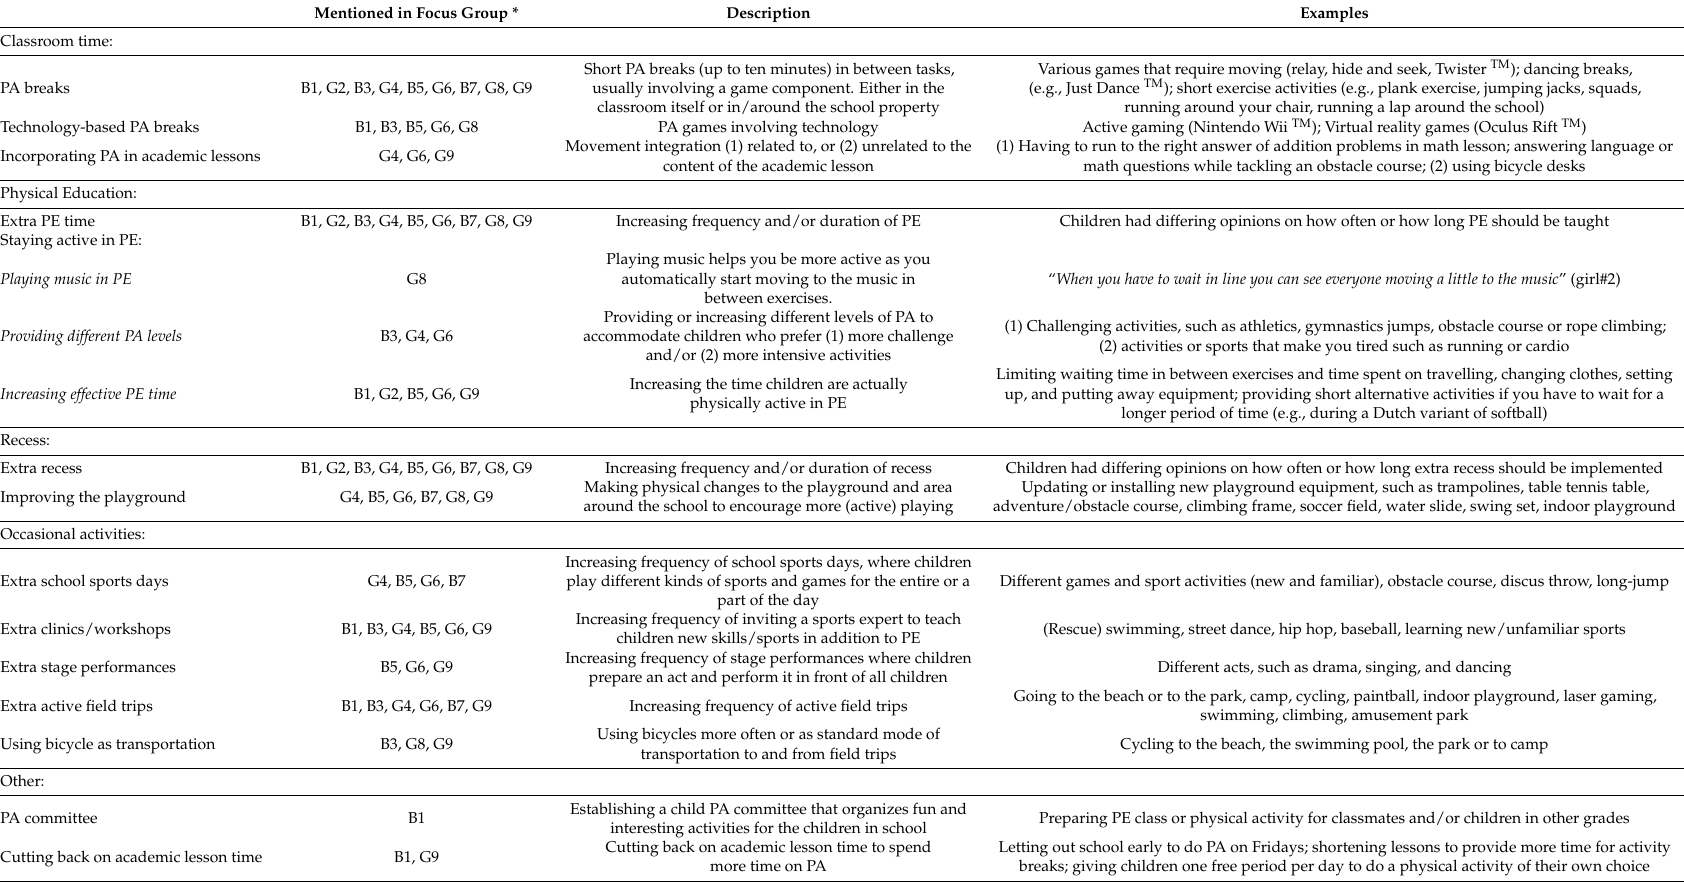
Table 3. Primary schoolchildren’s suggestions for integrating additional physical activity (PA) in